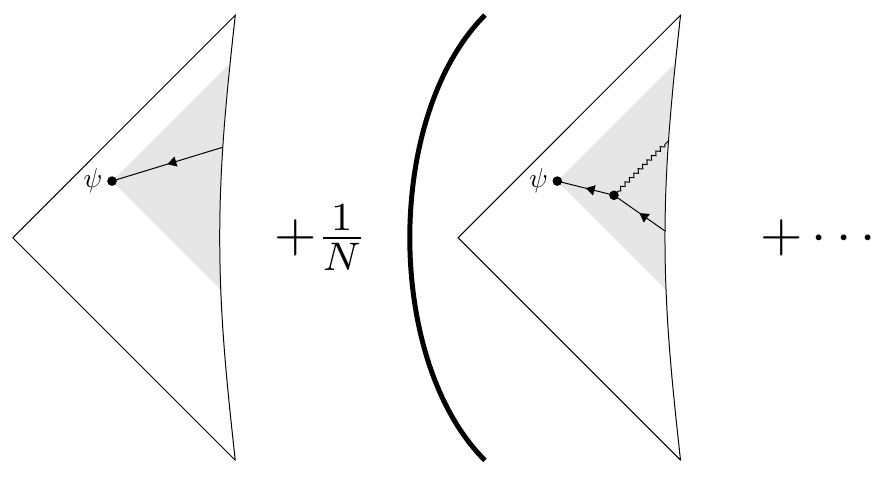
Figure 5. Illustration of the perturbative HKLL reconstruction, in the right Rindler wedge of AdS 2 . We show a diagram that appears at lowest, and at next-to-lowest order in the interaction. We will focus on the lowest order contribution; our kernels only have support on the right boundary, so to this order the fermion is reconstructed only from boundary operators inside the right light cone (indicated in grey). In the picture with the spacelike propagator G F as in (4.2), all the interaction vertices must be contained in the gray spacelike separated region. Fermion propagators are shown with a solid line, and the propagator of some putative scalar (cid:12)eld interacting with the fermion is drawn with a wavy